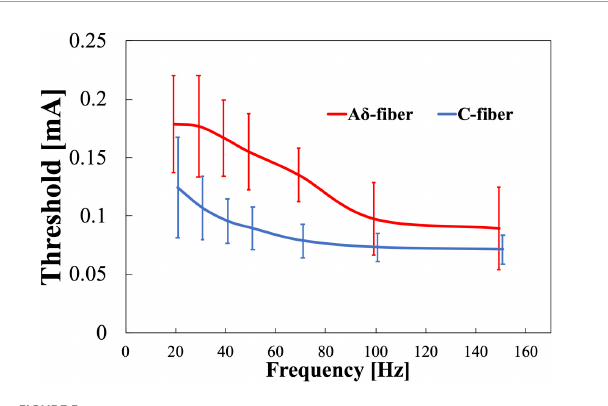
FIGURE5 Experimental pain threshold (mean value and standard deviation, n = 8). Variation with frequency in A δ - and C-fibers.